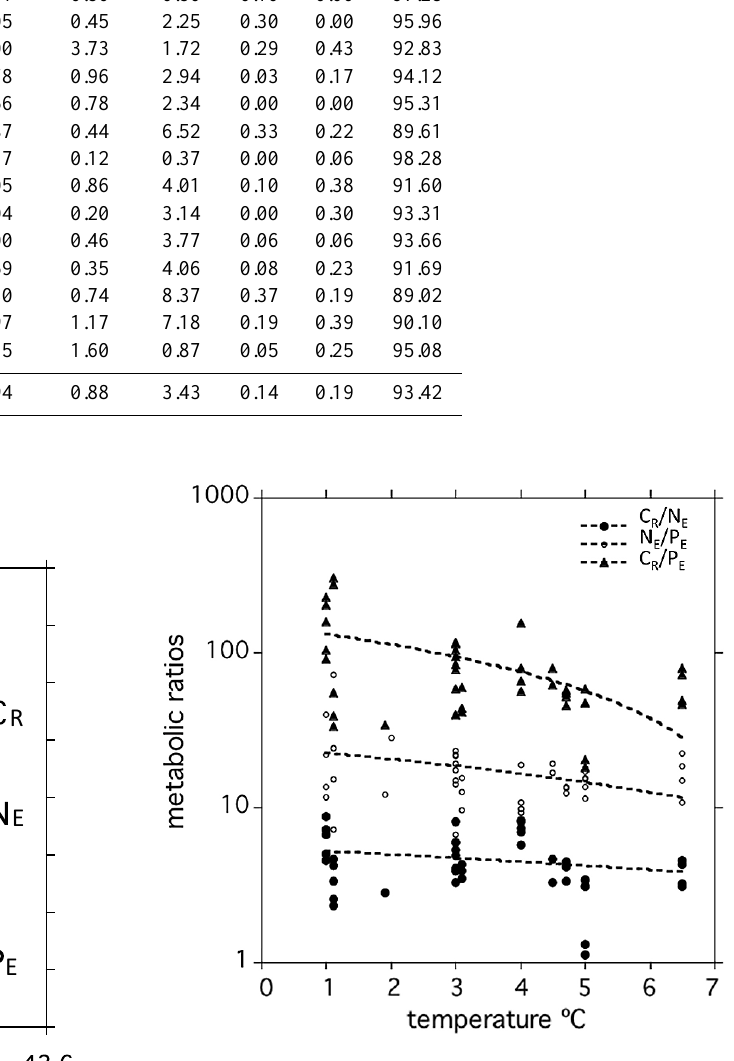
Fig. 5. Linear relationship between temperature and C R :N E , N E :P E and C R :P E ratios in atoms. Ordinates are in log scale. Metabolic rates as in Fig.